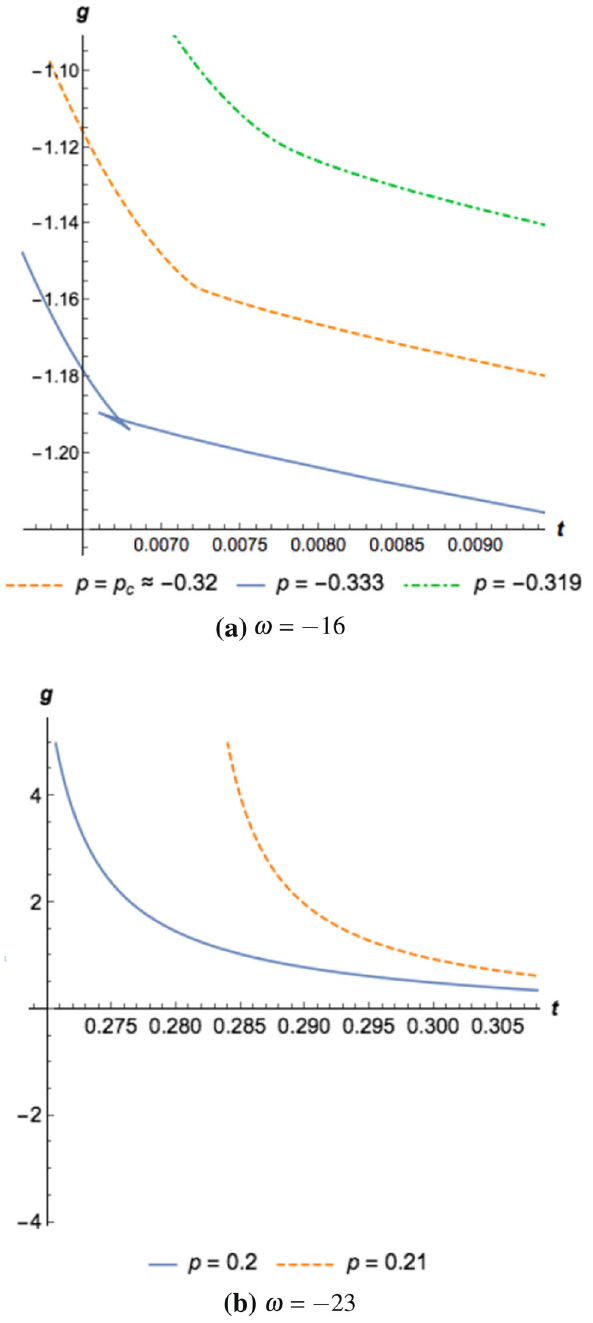
Fig. 4 g − t diagram for the cases ω = − 1 / 6 and ω = − 2 / 3